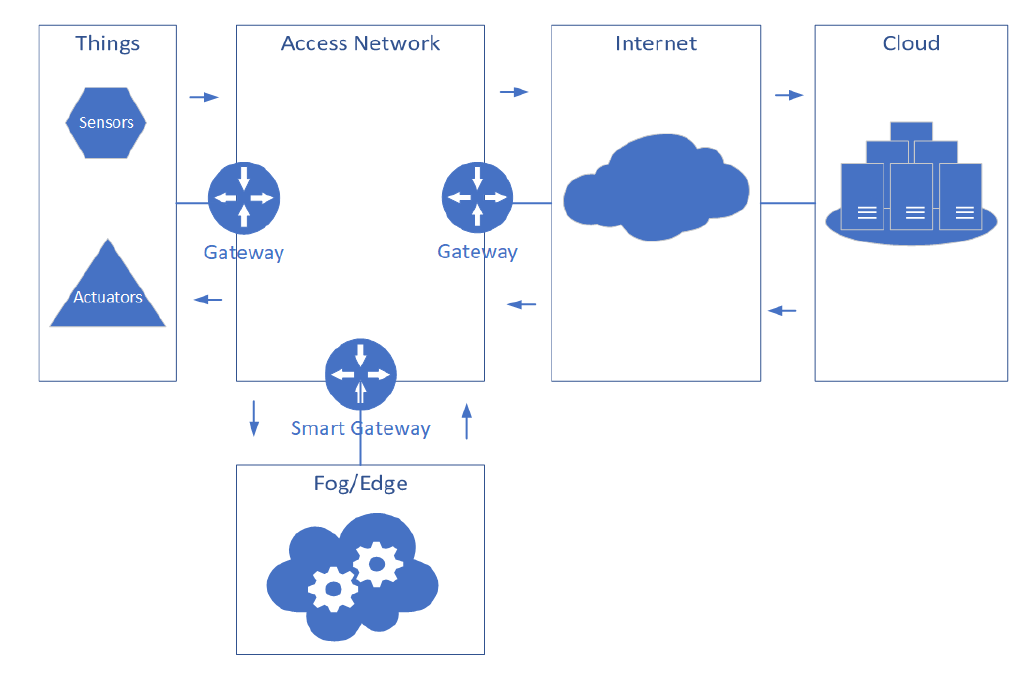
Figure 1. Internet of Things (IoT) ecosystem